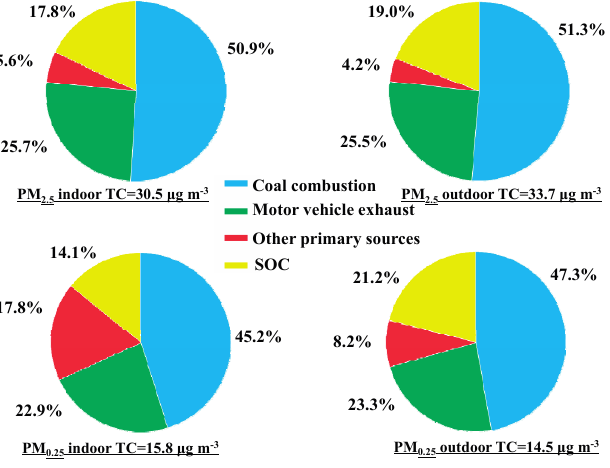
Figure 7. Relative contributions from different sources to TC in PM 2.5 and PM 0.25 inside the classroom and